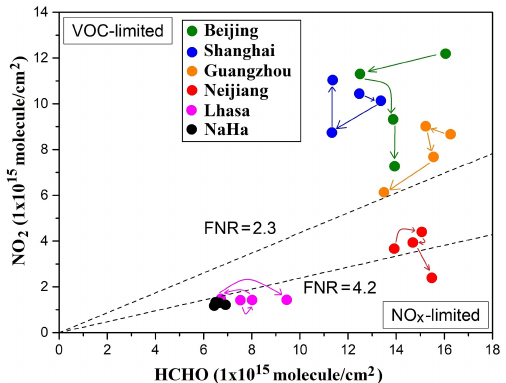
Figure 3. The change of O 3 formation sensitivity of six cities (Bei- jing, Shanghai, Guangzhou, Neijiang, Lhasa and Naha) in summer from 2016 to 2019. The arrows represent time step from 2016 to